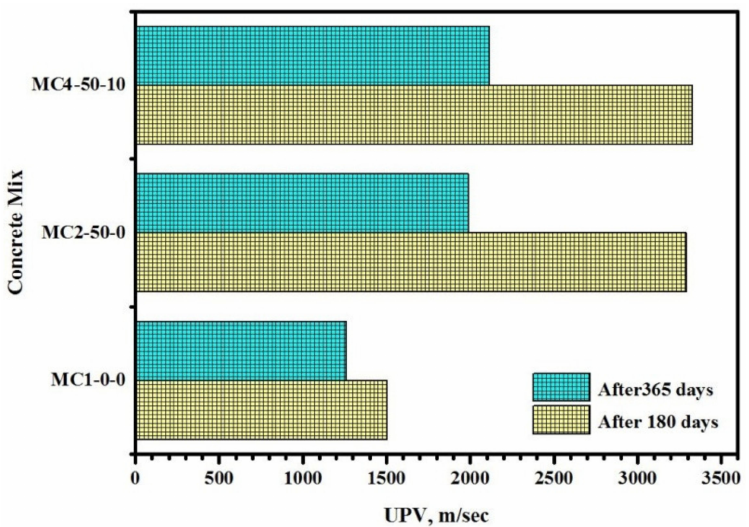
Figure 12. Influence of FA and EM on UPV readings of bio-concrete exposed to 10% of H 2 SO 4 solution.